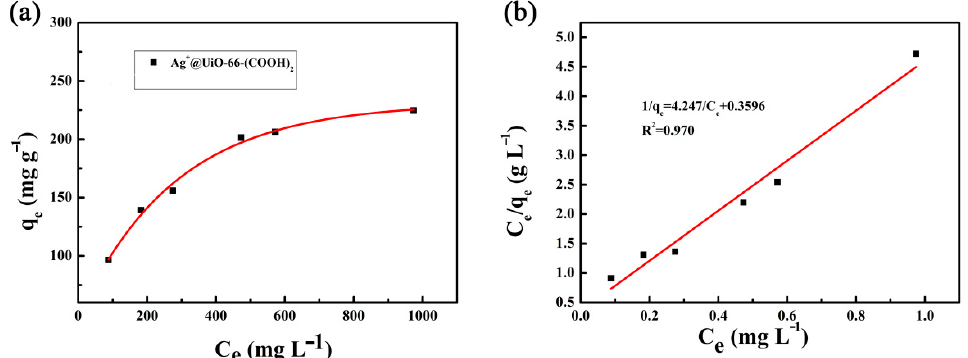
Figure 4. ( a ) Effect of initial concentration on the adsorption of I − by Ag + @UiO-66-(COOH) 2 ; ( b ) Langmuir isotherm models for the adsorption of I − .